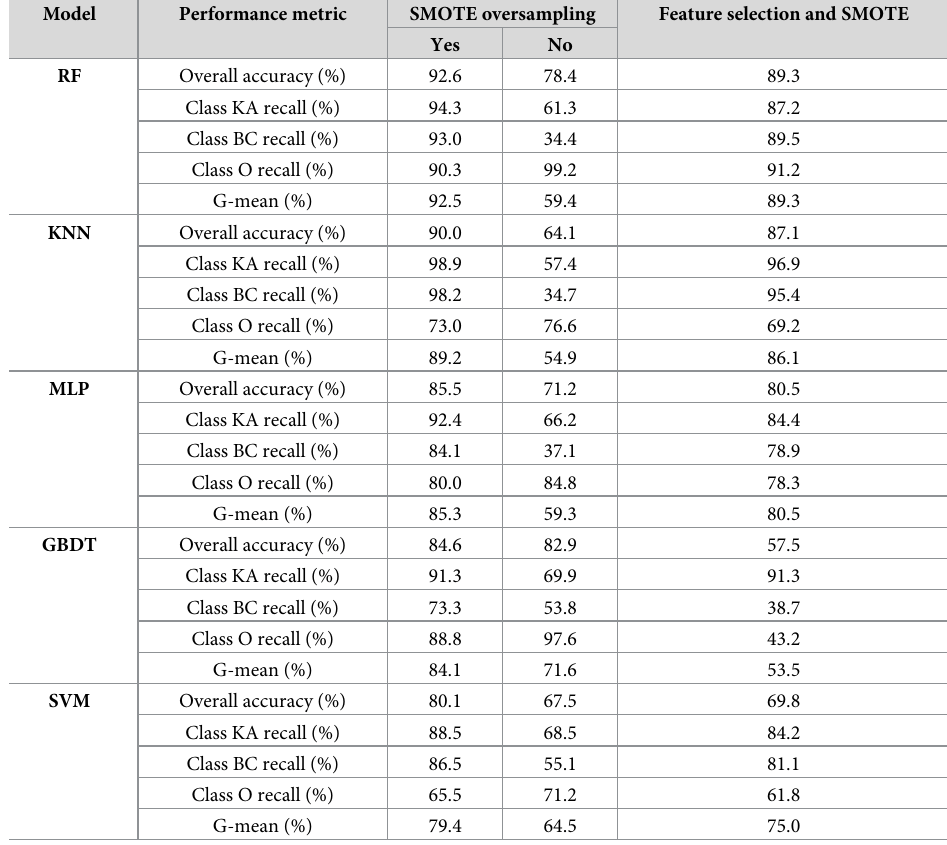
Table 3. Classification performance with/without data treatment for truck driver crash injury severity